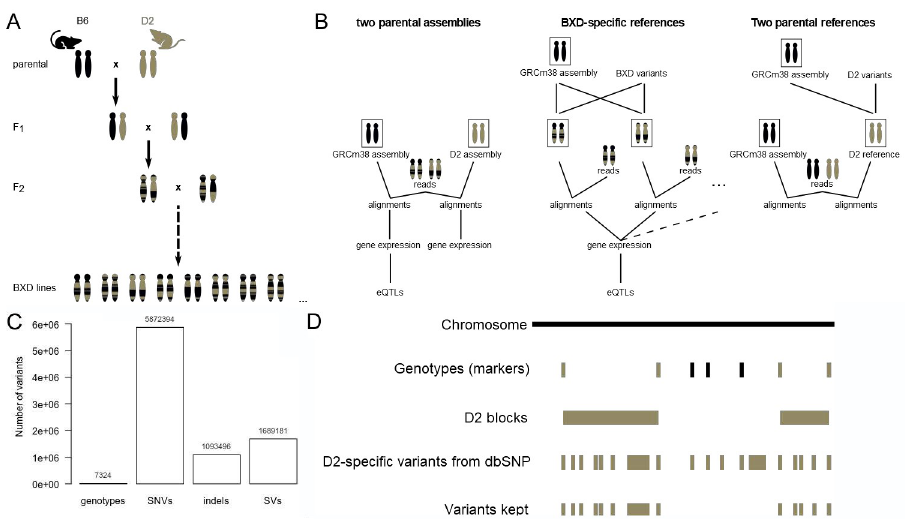
Fig 1. Overview of strategies to utilize genomic variants in transcriptome read mapping in inbred mouse lines. A. BXD mouse recombinant inbred panel. Samples came from mice that are: BXD advanced recombinant inbred lines, their parental inbred strains; i.e., C57BL/6J (B6) and DBA/2J (D2), and first generation cross between the parental strains (F1). B. The 3 RNA-seq read mapping strategies used in this study. In the ‘two parental assemblies’ strategy (left), the reads of all samples were mapped to the classical mouse genome assembly (GRCm38 or mm10) and to the D2 assembly. The ‘BXD-specific references’ (middle) were made from GRCm38 and BXD-specific variants. There is one reference for each BXD line, and the reads of each sample were mapped to the corresponding reference. The ‘two parental references’ (right panel) is an intermediate strategy in which the D2-specific reference was built from GRCm38 assembly and D2-specific variants. C. BXD genotypes available from GeneNetwork (genotypes) and D2-specific genomic variants (SNVs, indels, SVs) available from dbSNP. D. Genotypes imputation workflow. D2 haplotype blocks were delineated based on available genotypes in the BXD lines. D2-specific variants within these D2 blocks were included in the BXD-specific references. B6 regions or alleles are in black, D2 regions or alleles are in